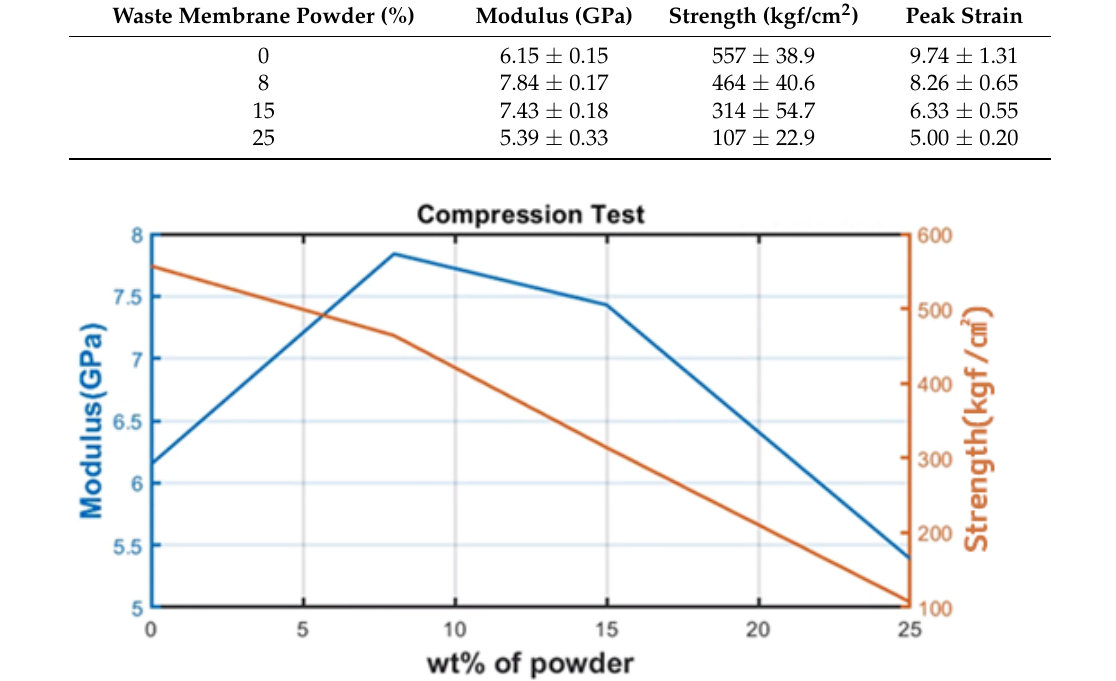
Figure 2. Powder-containing mortar compression test result graph.